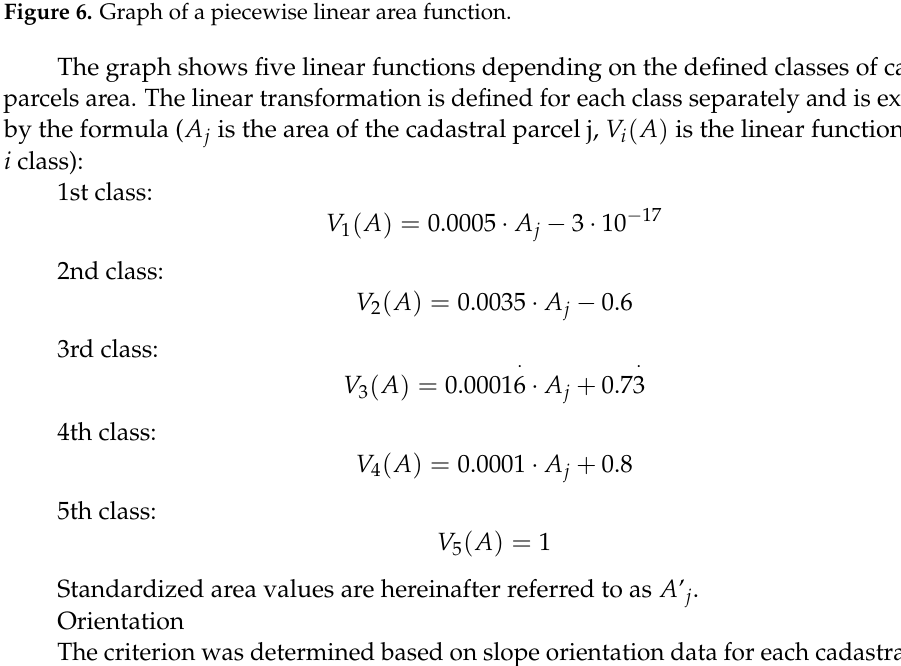
Figure 6. Graph of a piecewise linear area